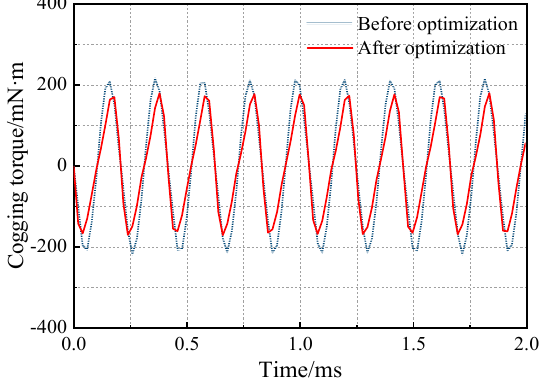
Figure 18. Comparison of the output voltage of the claw pole rotor before and after optimization.